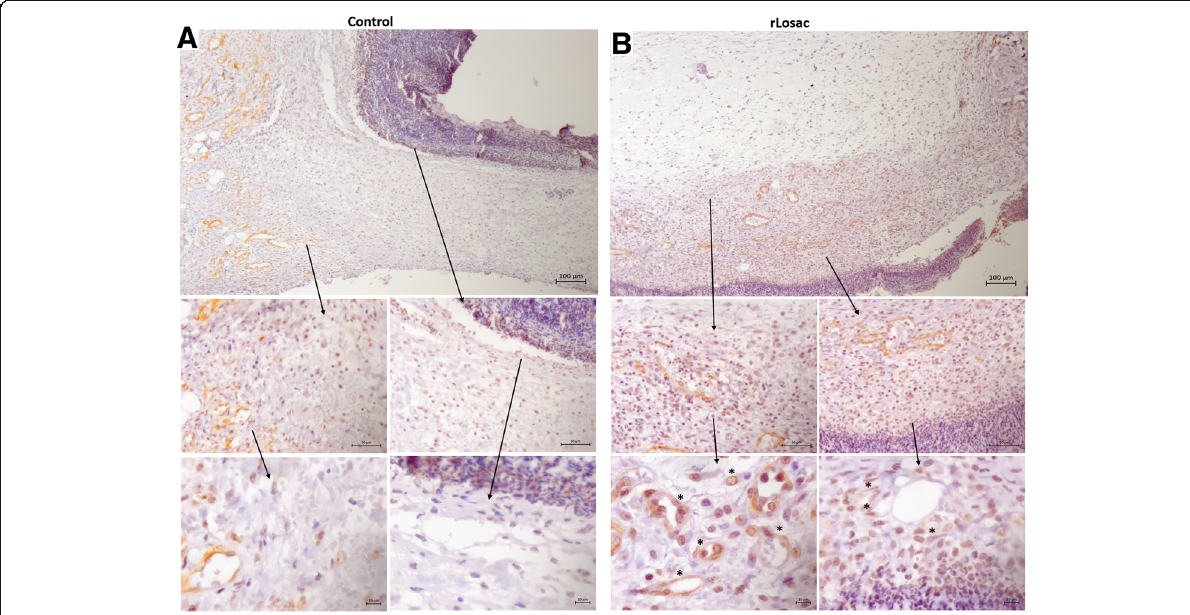
Fig. 6 Assessment of scar tissue by immunochemistry – α -SMA from the group treated during experimental period. Micrographies of scar tissue evaluated after day 3 ( a control group; b treated group). All are shown at magnifications of 100, 40 and